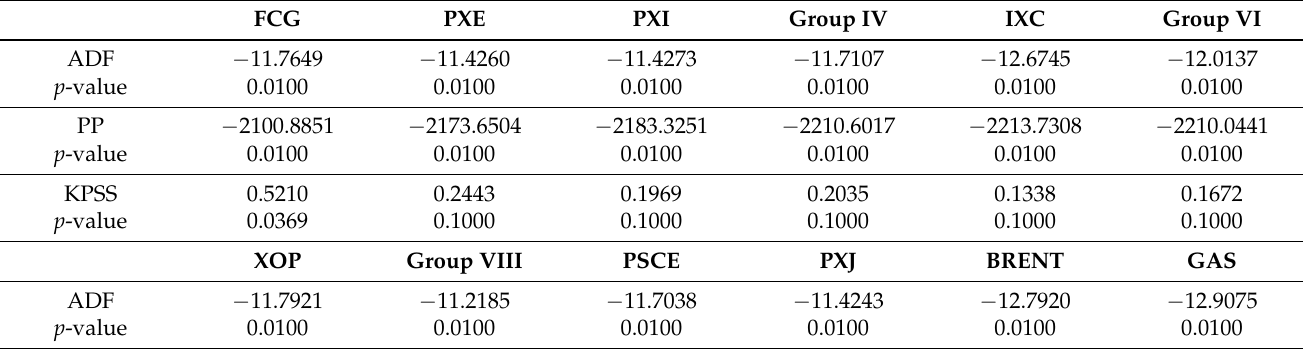
Figure A4. Percentage logarithmic rates of return of oil, gas, and ETFs. Table A4. Unit root